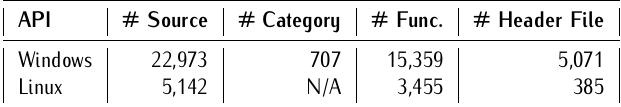
Table 1. API error specifications mined by RVM. For Windows, the column “Sources” refers to URLs. For Linux, it refers to man